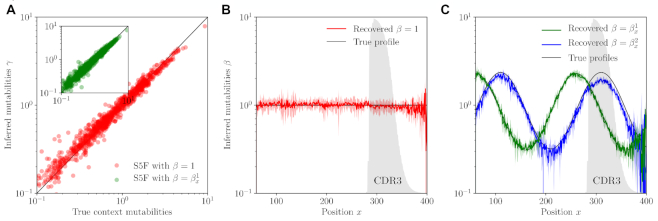
Validation of the SHM model inference framework on synthetic data generated with the S5F model (16). (A) Inference of context mutabilities γ\documentclass[12pt]{minimal}
\usepackage{amsmath}
\usepackage{wasysym}
\usepackage{amsfonts}
\usepackage{amssymb}
\usepackage{amsbsy}
\usepackage{upgreek}
\usepackage{mathrsfs}
\setlength{\oddsidemargin}{-69pt}
\begin{document}
}{}$w$\end{document}. (B,C) Inference of position mutabilities βx for flat (B) and sinusoidal (C) profiles. Error bars correspond to \documentclass[12pt]{minimal}
\usepackage{amsmath}
\usepackage{wasysym}
\usepackage{amsfonts}
\usepackage{amssymb}
\usepackage{amsbsy}
\usepackage{upgreek}
\usepackage{mathrsfs}
\setlength{\oddsidemargin}{-69pt}
\begin{document}
}{}$95\%$\end{document} confidence intervals. The frequency at which a given position belongs to the CDR3 region is indicated with the grey shaded area.